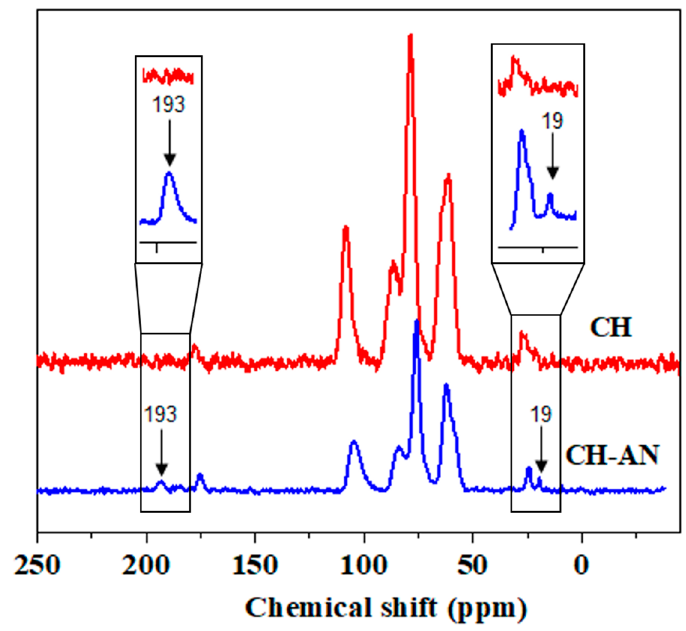
Figure 2. Carbon NMR spectra in solid state of CH-based bio-composites, that is, pristine CH bio-composite (red line) and chemically modified CH-AN bio-composite (blue line).